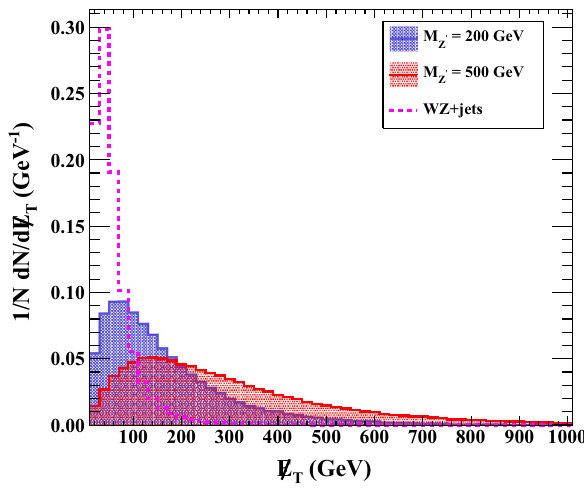
Fig. 11 Normalized missing energy ( (cid:3) E T ) distribution for the 3 μ + (cid:3) E T final state. We show the distribution for the signal for M Z (cid:2) GeV, g μμ = 0 . 20, g bb = 4 . 2 × 10 − 3 , and for M Z (cid:2) = 500 GeV, g μμ = 0 . 48, g bb = 1 . 1 × 10 − 2 . We also show the analogous distributions for the W Z